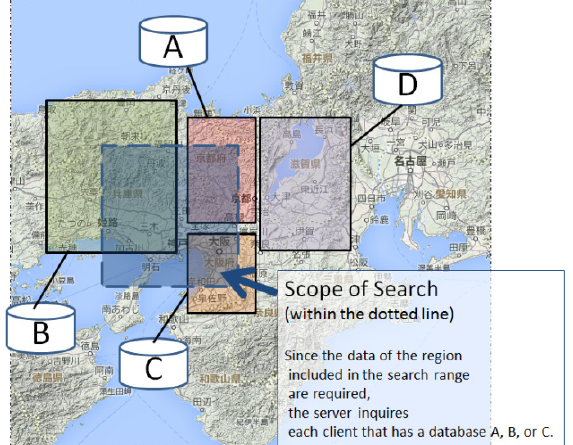
Fig. 2. An example of query decomposition. The map used is taken from Google Maps.